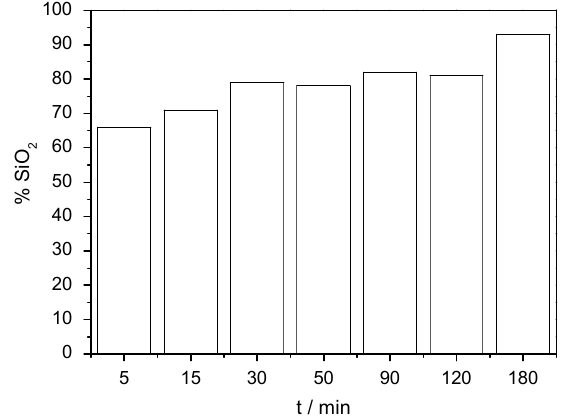
Figure 6. SiO 2 concentration in DW as a function of dissolution time.